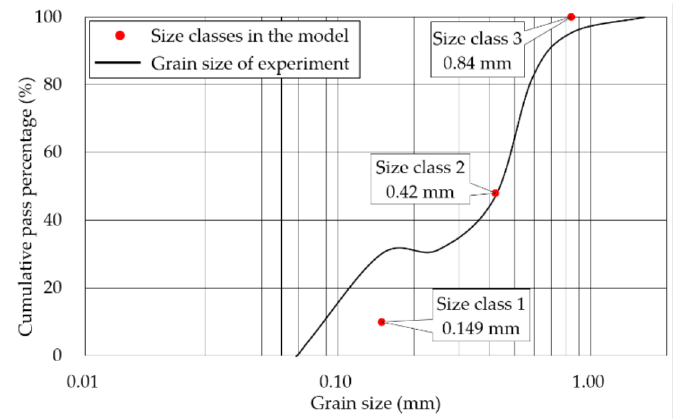
Figure 8. Bed material grain size distribution of the experimental